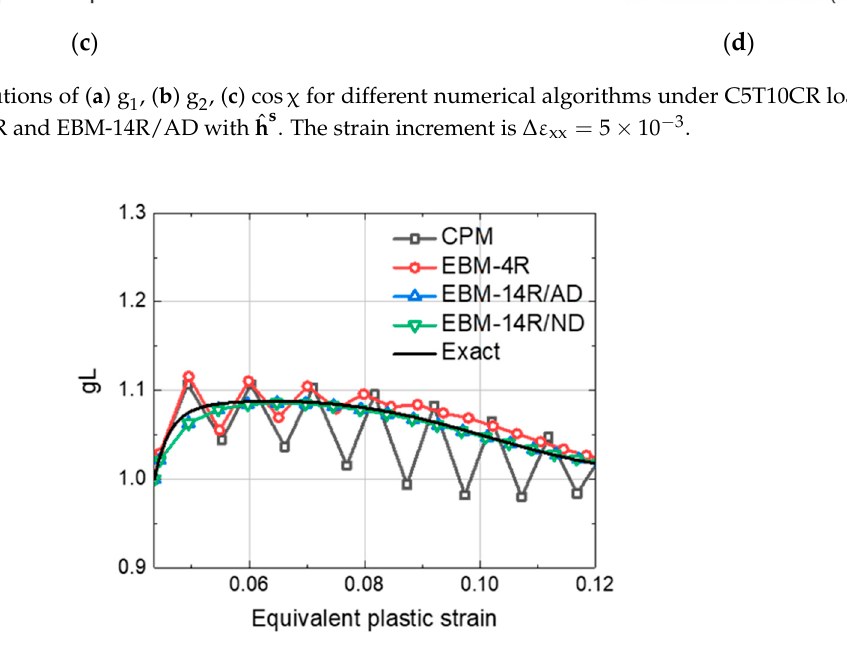
Figure 12. Evolution of g for different stress integration algorithms under the loading path C3T10CR L with strain increment, ∆ ε xx = 5 × 10 − 3 . Table 5. Average relative errors in the flow curves and r − values of MAT 1 under C5T10CR. Algorithm